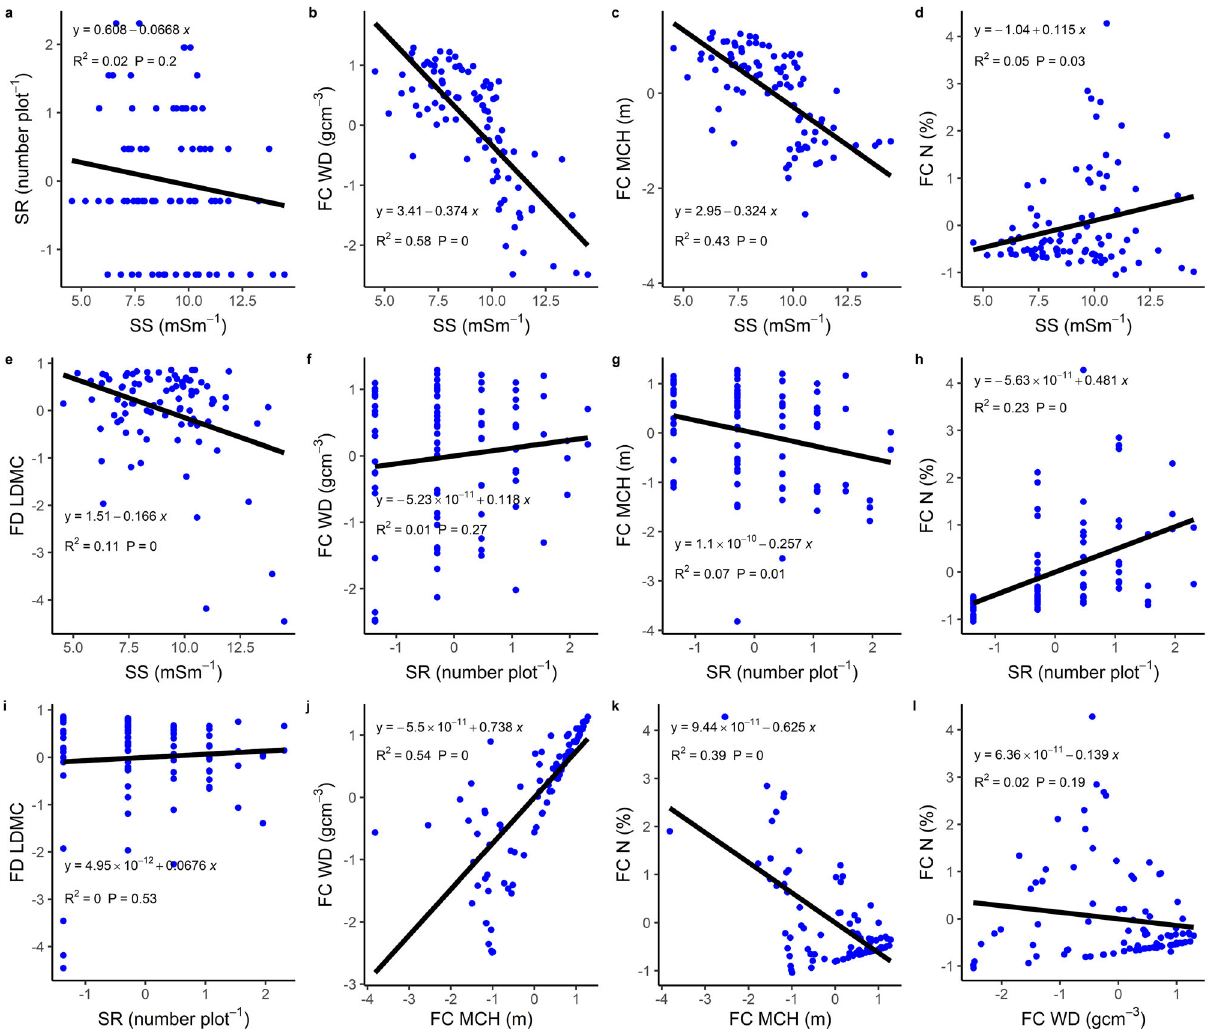
Fig. 2 Bivariate relationships between sediment salinity (SS), species richness (SR), functional composition, and functional diversity of different traits for hypothesized causal paths in the structural equation models. a – l Sediment salinity- versus species richness ( a ), -functional composition wood density (FC WD; b ), -functional composition maximum canopy height (FC MCH; c ), -functional composition litter nitrogen (FC N; d ), -functional diversity leaf litter dry matter content (FD LDMC, e ); species richness- versus functional composition wood density ( f ), -functional composition maximum canopy height ( g